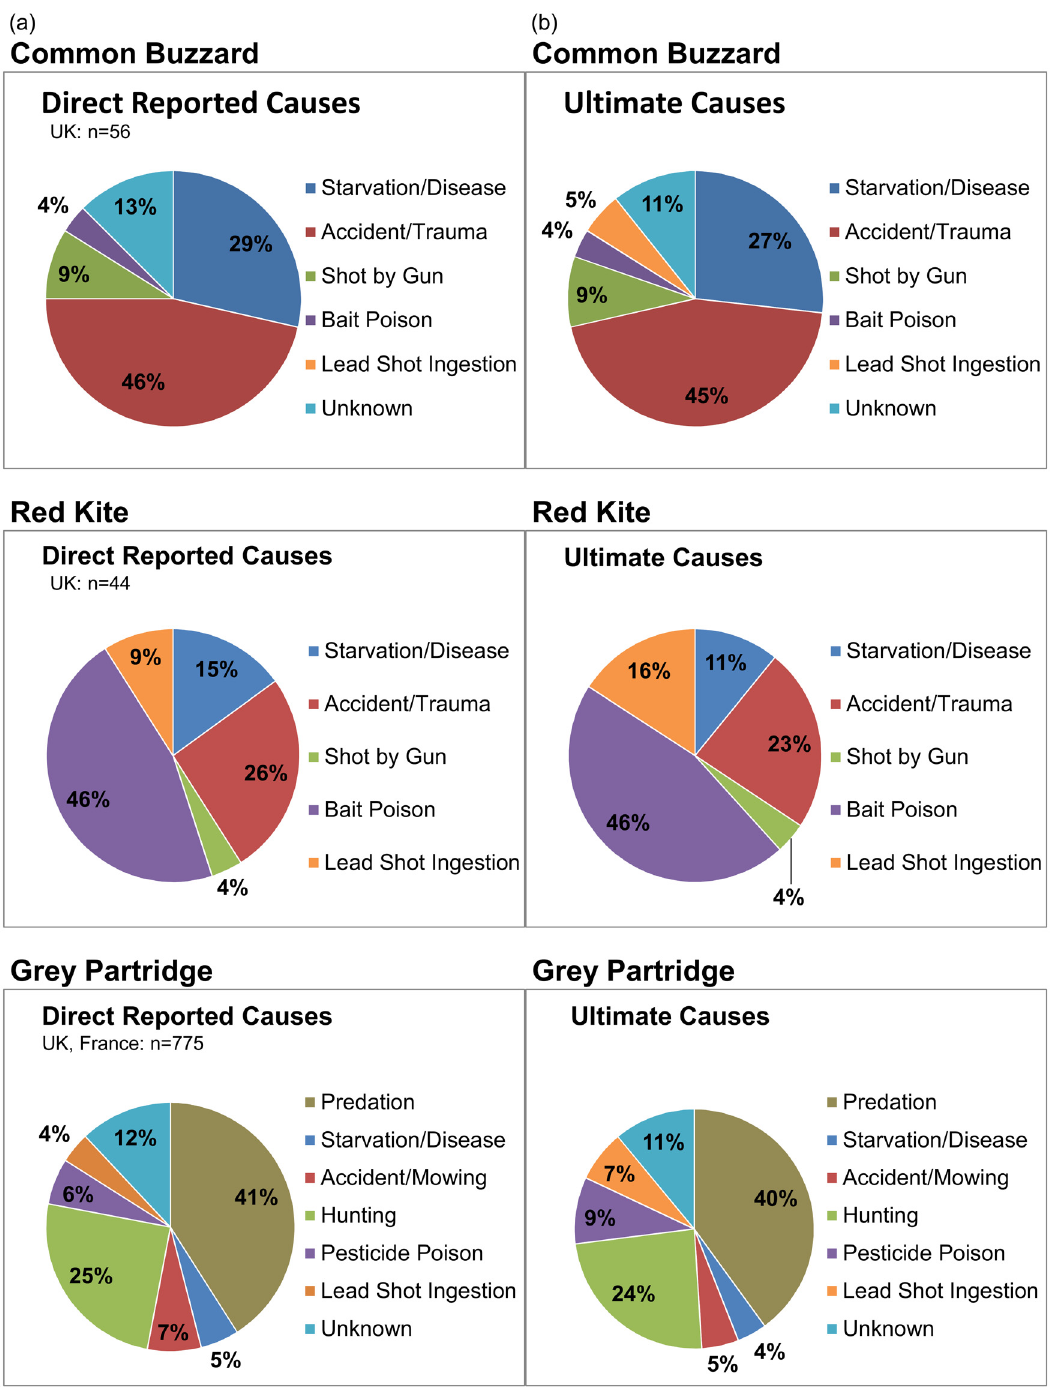
Fig 1. Estimated percentages of mortality attributable to various causes (n = number of birds) [10, 20 – 23, 25]. Direct reported causes are proximal causes of death and represent lower-bound estimates of contribution of ingestion of lead shot and poison to mortality in selected study areas used in the modeling exercise (a, left panel). Possible ultimate causes by lead shot or poisoning (see text) were added to the reported percentages to represent upper- bound estimates (b, right panel).